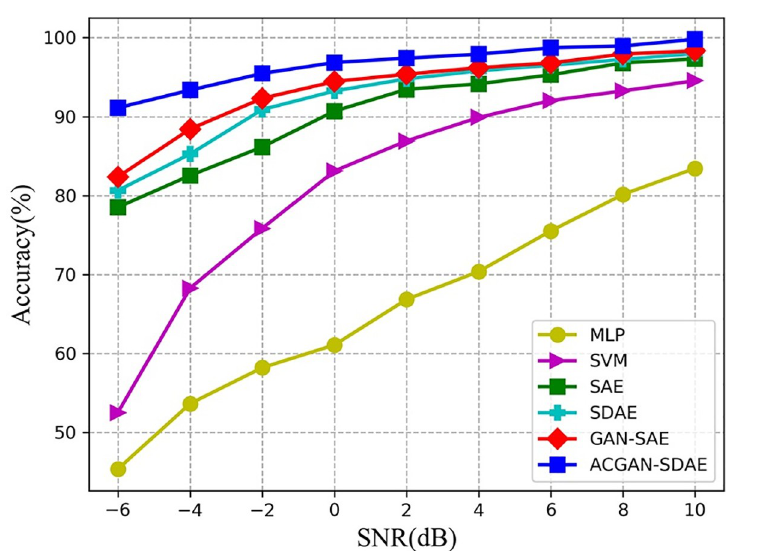
Fig 13. Diagnosis results of six diagnosis models under different SNRs.